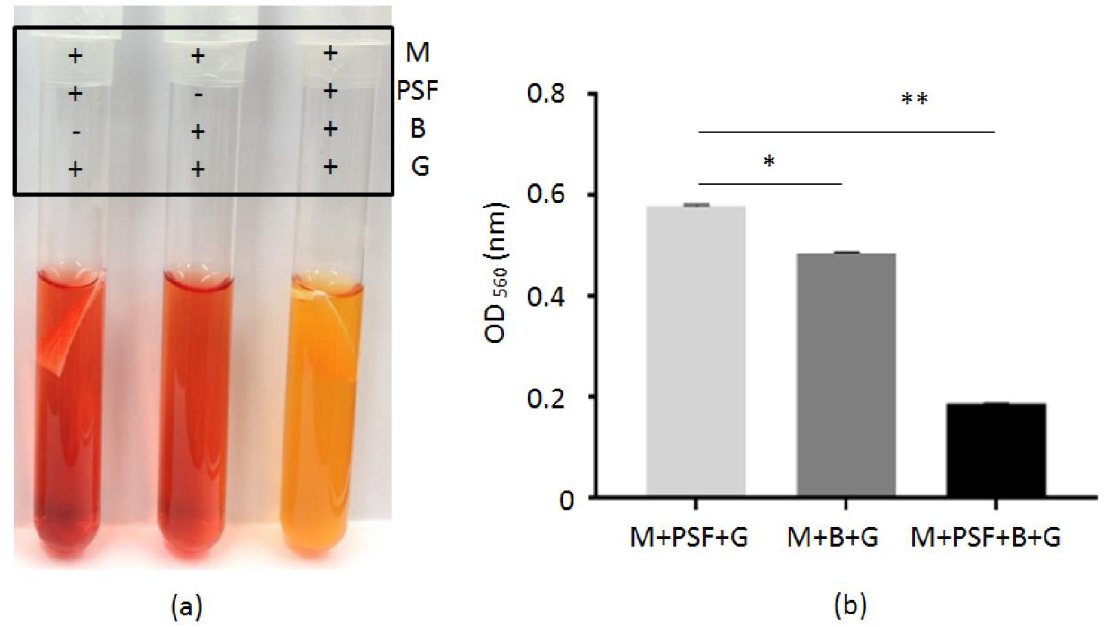
Figure 2. Fermentation activity of S. epidermidis . ( a ) PSF MTAM loaded-bacteria (B) (10 5 colony-forming unit (CFU)/mL) were incubated in phenol red-containing rich media (M) with glycerol (G). Rich media plus glycerol with a bacteria-unloaded PSF MTAM (PSF) alone or bacteria alone were included as controls. S. epidermidis fermentation on 10 h was displayed. A yellow color change in media is indicative of extensive fermentation of bacteria. ( b ) The OD 560 value in the media with glycerol plus PSF MTAM loaded-bacteria (M+PSF+B+G) was significantly lower than those in the media with glycerol plus PSF MTAM (M+PSF+G) or bacteria (M+B+G). Results were illustrated as the mean ± standard derivation (SD) of three independent experiments. * p < 0.01; ** p < 0.001 (two-tailed t -tests).